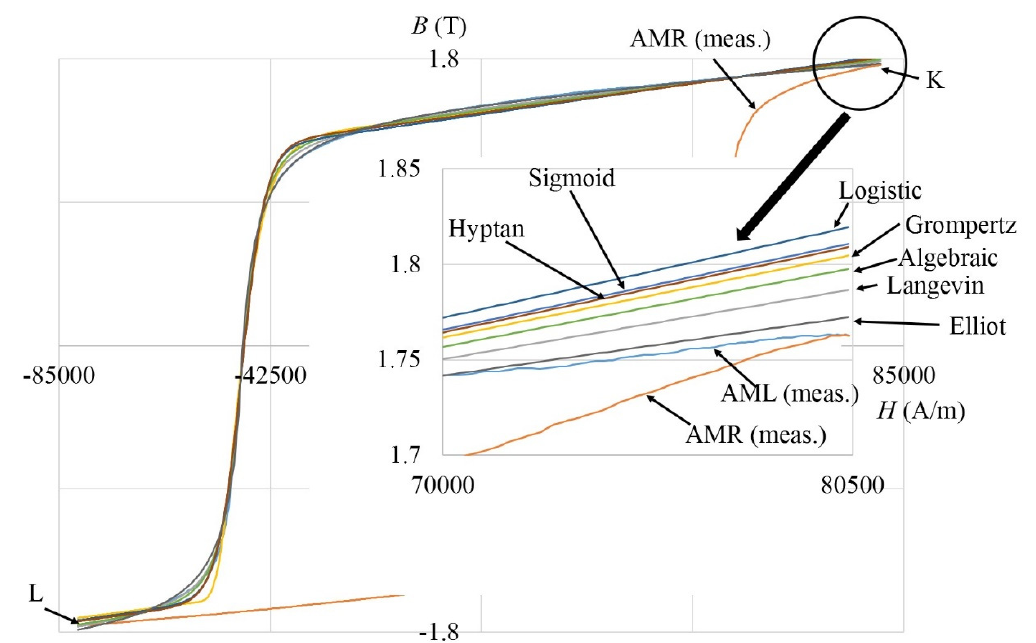
ff erent expressions for Figure 5. Graphically presented different expressions for AML. Figure 5. Graphically presented di Figure 5. Graphically presented different expressions for AML.